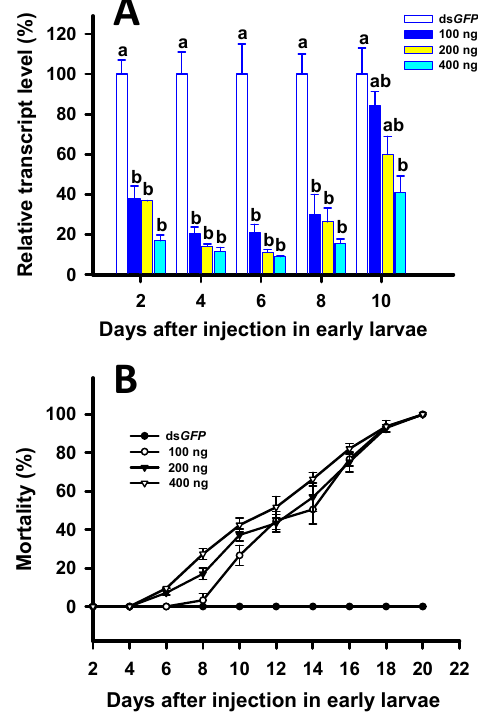
Figure 5. Time-dependent suppression of TcLgl transcript in early (8-day) larvae of T. castaneum injected with ds TcLgl at 100, 200, and 400 ng/larva or ds GFP at 400 ng/larva as determined by RT-qPCR ( A ); and the time-dependent larval mortalities in the ds TcLgl and ds GFP -treated larvae ( B ). The relative expression levels (%) are presented as the mean and standard errors of three replicates; each was performed with a RNA sample prepared from four insects and each sample was run with two technical replicates. The percent mortalities were also determined based three replicates for each dsRNA dose; each replicate with at least 40 early larvae. Different letters above the standard error bars indicate significant differences based on ANOVA followed by Tukey’s HSD multiple comparison test ( p < 0.05) within the same time